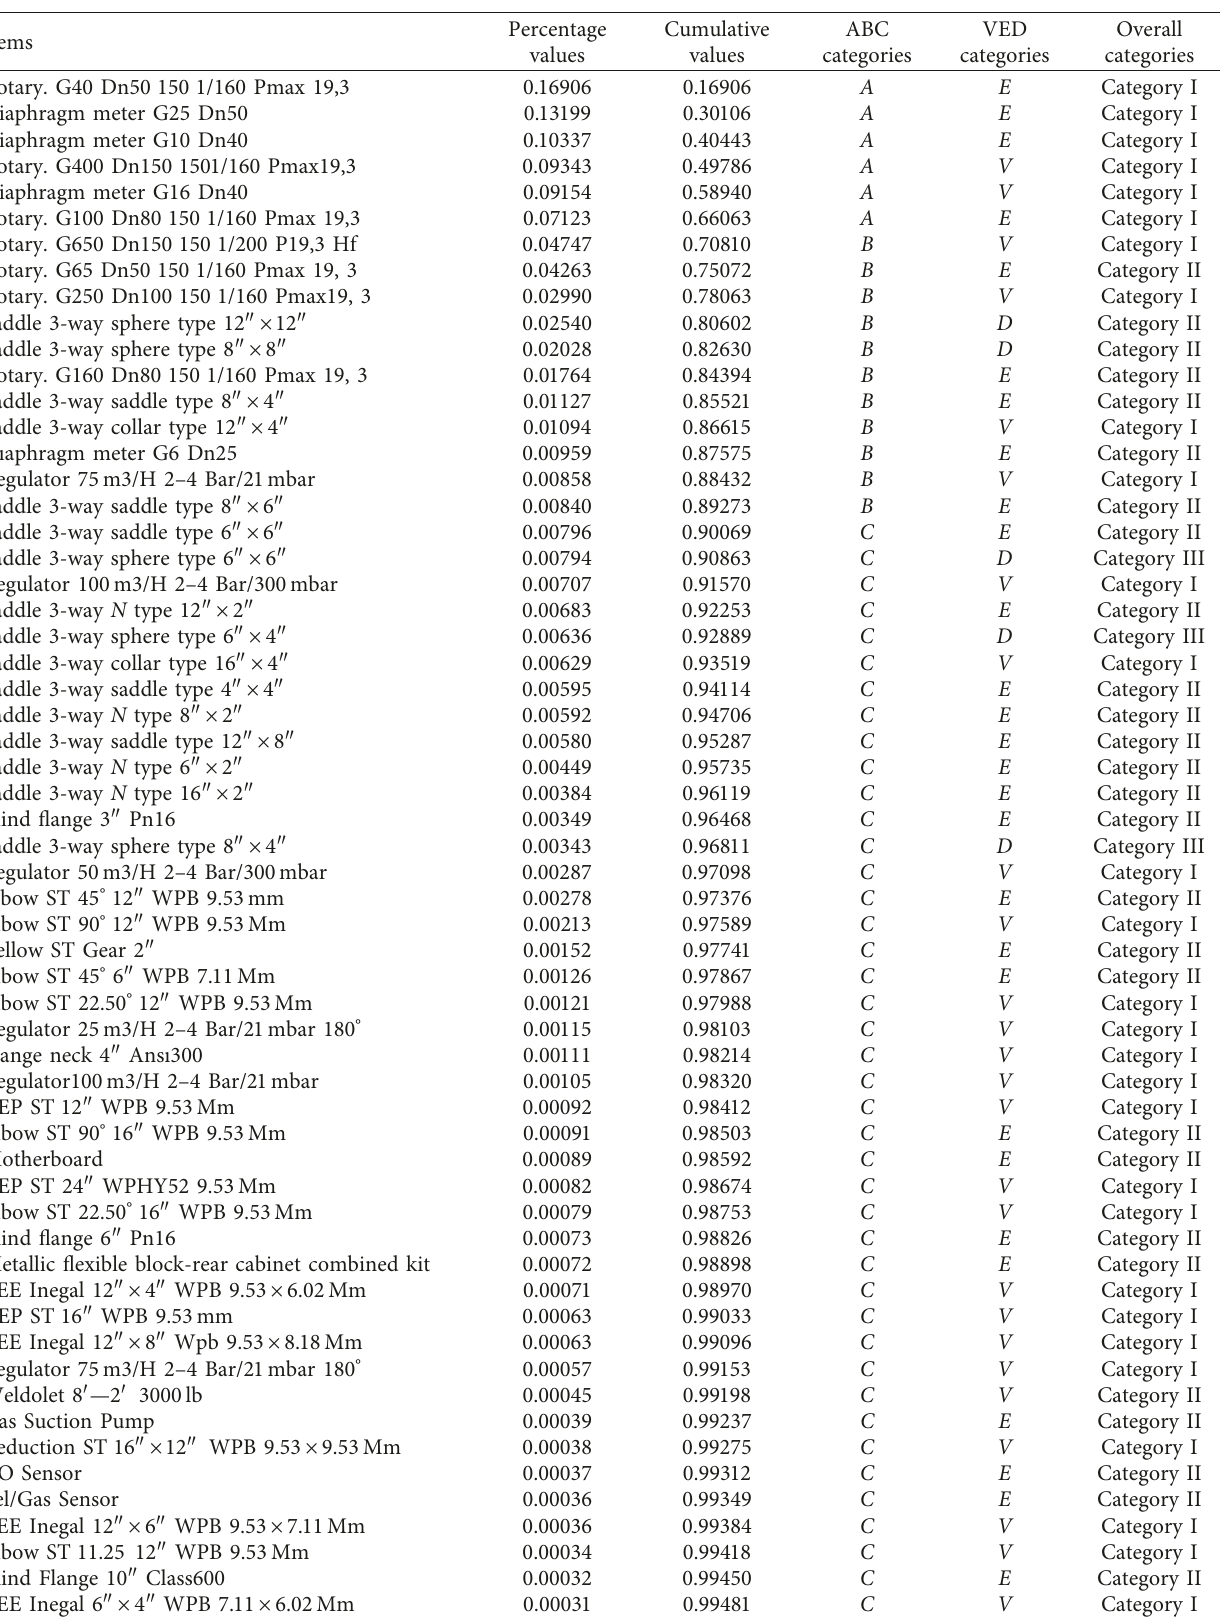
Table 4: Stage 1